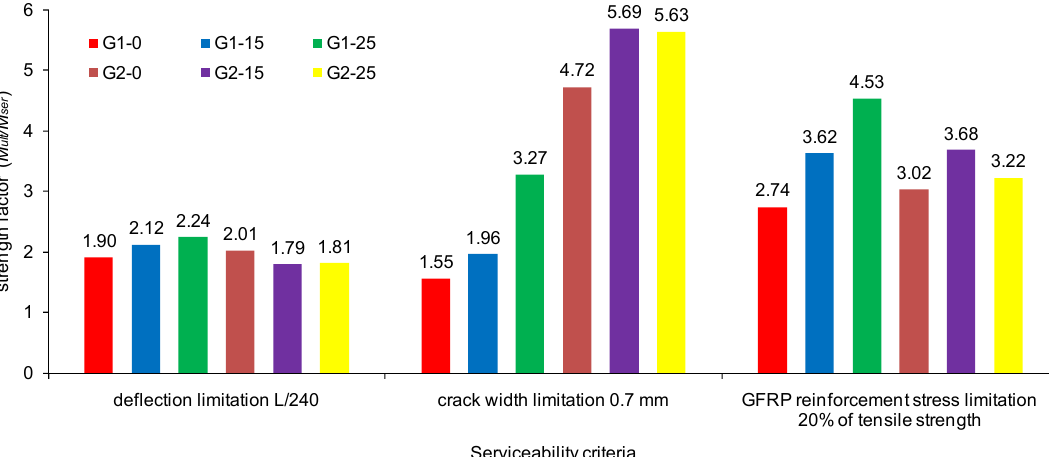
Figure 12. Strength factors for serviceability criteria limitations for the tested beams.